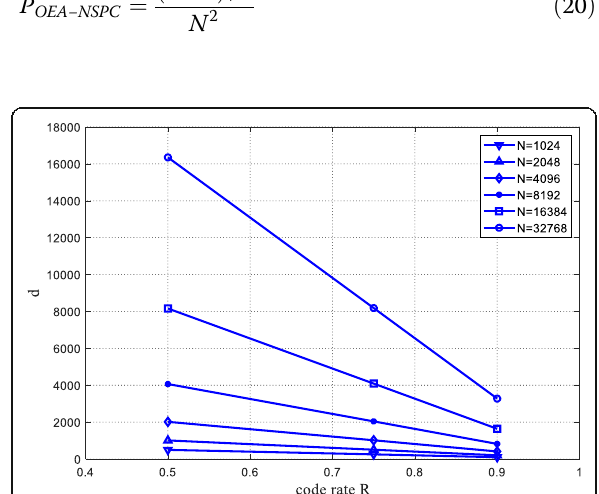
Fig. 11 Variation trend of d with code rate R : The ordinate in a linear form. The relation between d and R is in linear for each of code length N . The value changes of p fi can be negligible to a code length